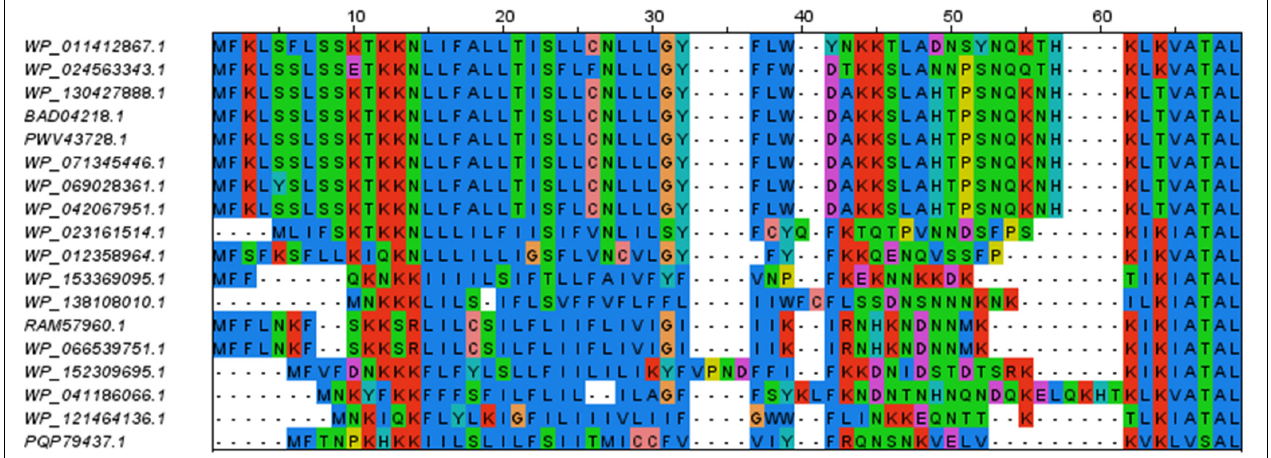
FIGURE 3 | Sequence alignment of the N-terminal residues of members of the NlpA family. The remaining of the alignment (C-terminal parts) is not shown. The color code is the same as in Figure 1 . Positively charged residues and stretch of hydrophobic residues of the signal peptides are well